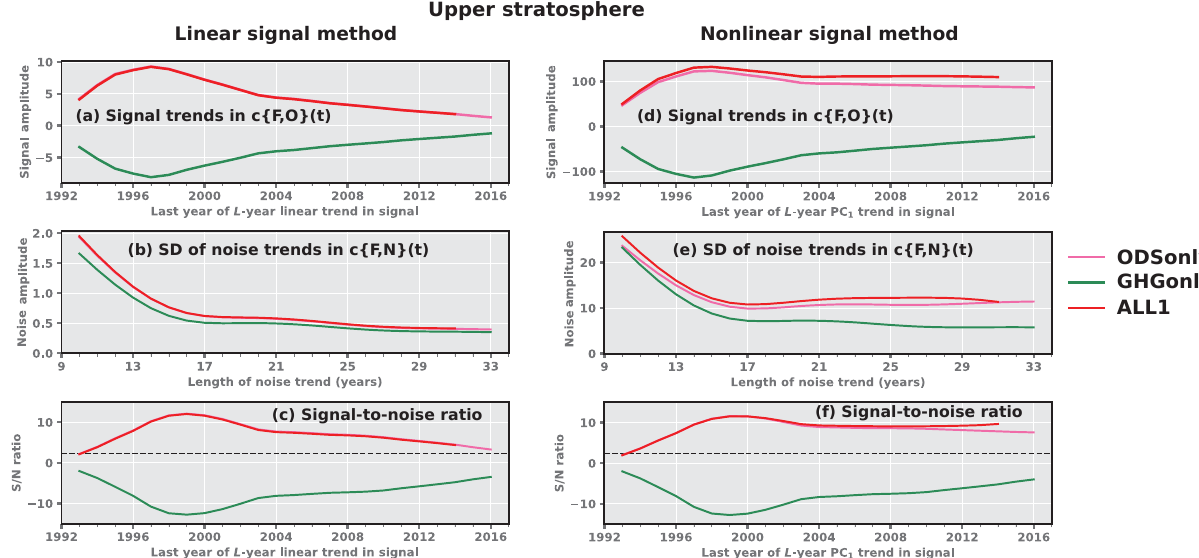
Figure 7. Results from the S/N analysis of simulated and observed changes in zonal-mean upper- and lower-stratospheric ozone. Signal time series provide information on the similarity between the time-invariant ODSonly, GHGonly, or ALL1 fingerprint pattern and the time-varying observed patterns of stratospheric ozone change. Signal detection relies on both simple linear regression ( a–c ; method 1) and regression between c { F,O } (t) and the leading PC of the ODSonly, GHGonly, or ALL1 simulation ( d–f ; method 2). Results are a function of the analysis period L (in years). The L -year trends in the method 1 and method 2 signal time series are plotted in the top row. The year on the abscissa is the end year of the L -length trend beginning in 1984. Noise time series indicate the level of similarity between the searched-for ODSonly, GHGonly, and ALL1 fingerprints and the concatenated CTL, NAT-h, and NAT estimates of natural variability in ozone. The middle panels show the SD of the distribution of maximally overlapping L -year trends in c { F,N } (t) . The S/N ratio is shown in the bottom panels. The dashed horizontal line indicates the stipulated significance level of 1% for signal